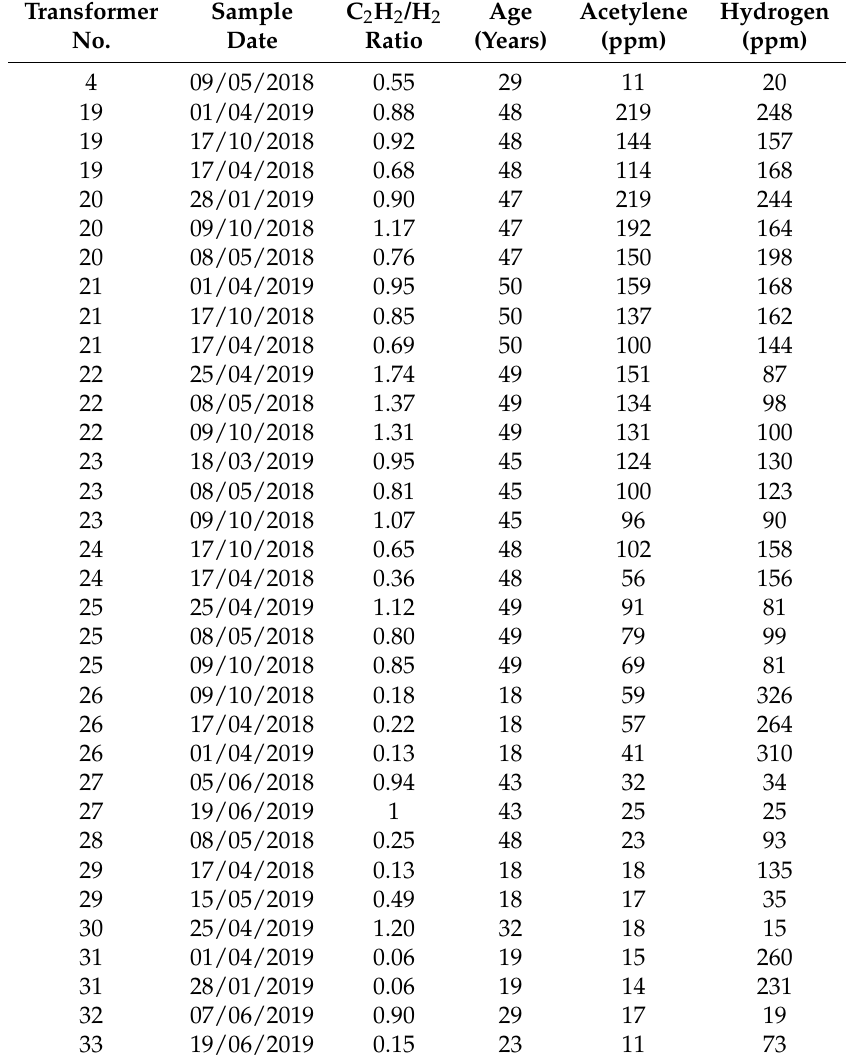
Table 6. Transformer data with the C 2 H 2 /H 2 ratio less than 2 and a high C 2 H 2